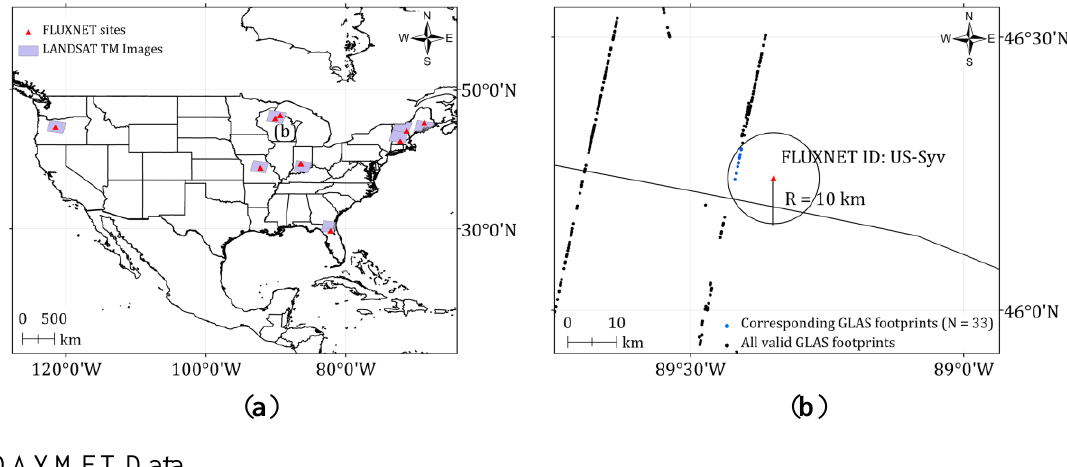
Figure 2. ( a ) The 12 selected FLUXNET sites (red triangles) based on the distance from valid GLAS footprints (≤ 10 km radius). ( b ) An example site (ID: US-Syv) located at the Sylvania Wilderness Area of Michigan. Purple polygons represent Landsat TM imagery for the retrieval of Leaf Area Index (LAI). Blue dots refer to valid GLAS footprints corresponding to the FLUXNET